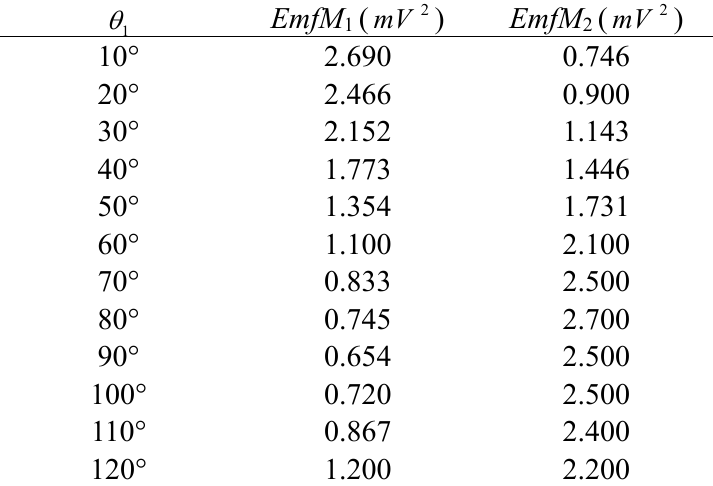
Table 2. The power Emf signal produced by a sensor module in the bending angle experiment.